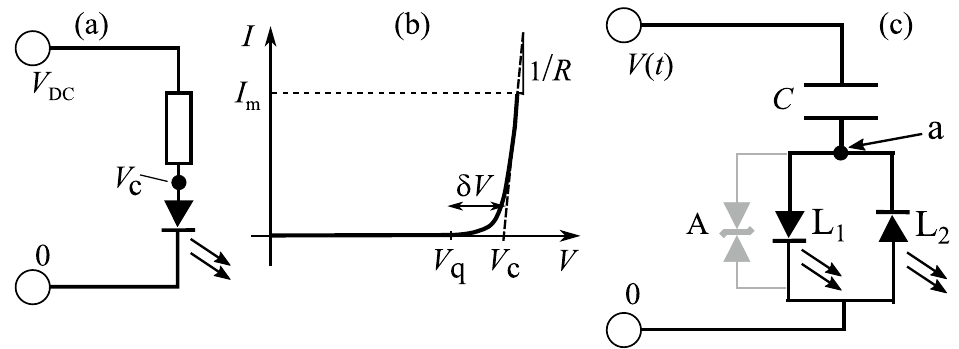
Figure 1. ( a ) A series limiting resistor for a DC-driven LED to prevent excessive current greater than a failure current I m . ( b ) The I – V characteristic of an LED is really exponential in the forward direction around V c , starting at a voltage V q say. We approximate I ( V ) by an initially very high resistance region followed by a low (differential) resistance R region above threshold V c . ( c ) An anti-parallel pair of LEDs, L 1 and L 2 , in series with a capacitor C . These two LEDs could also represent two anti-parallel chains of LEDs. Conduction through L 1 or L 2 starts when the voltage at point a in the circuit (below the capacitor) is V c or − V c respectively [light lines: A transient voltage suppressor (TVS) diode (A) in parallel with the LED chains to avoid current surges at first